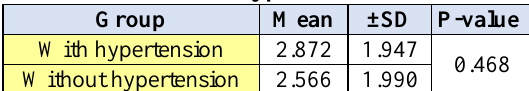
Table 3: Probing pocket depth mean and